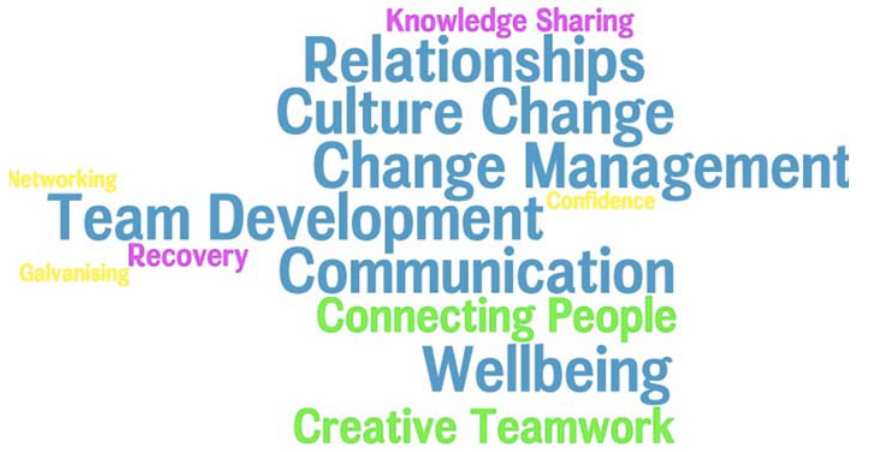
Figure 2. A wordle-analysis of the outcomes from the Recovery Co.